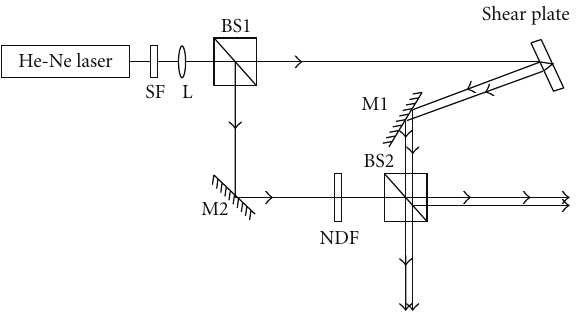
Figure 11: Experimental setup for the Mach-Zehnder interferome- ter configuration with shear plate inducted in one